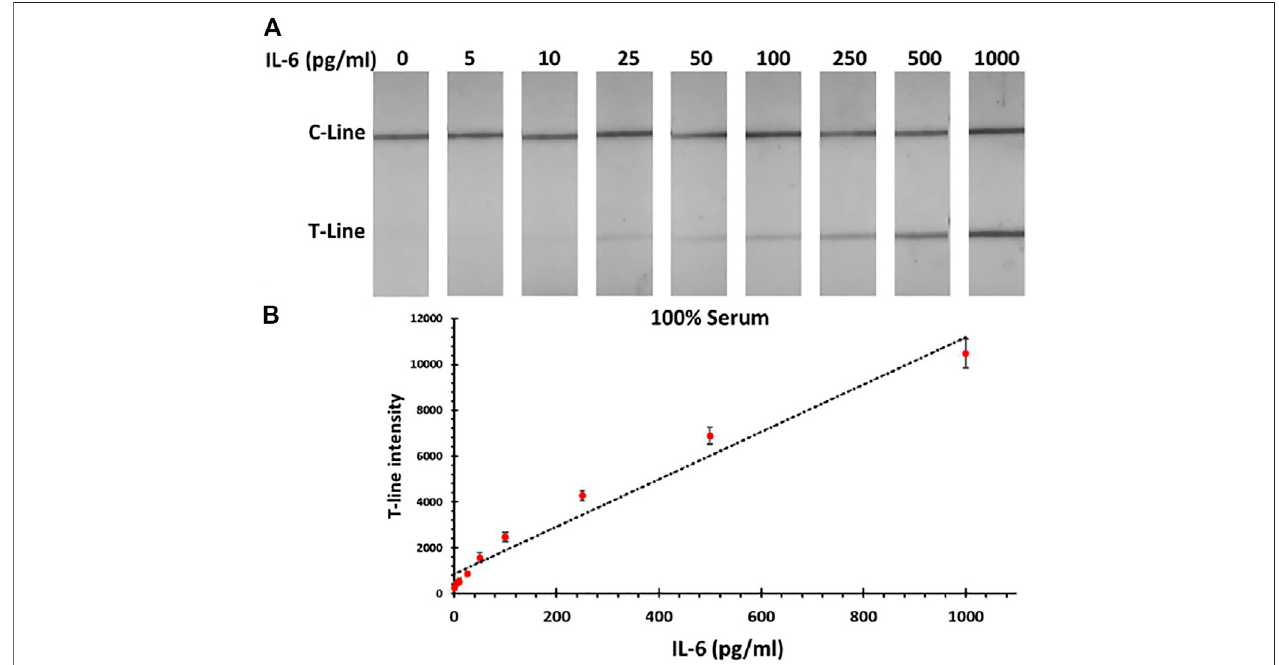
FIGURE 3 | (A) Photographs of LFA strips for detection of IL-6 in human serum samples after applying the silver ampli fi cation technique. (B) Corresponding calibration curve for IL-6 detection in serum sample.